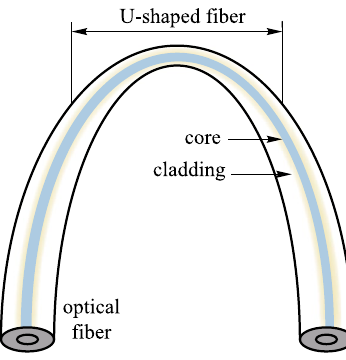
Fig. 12 Schematic diagram of the U-shaped